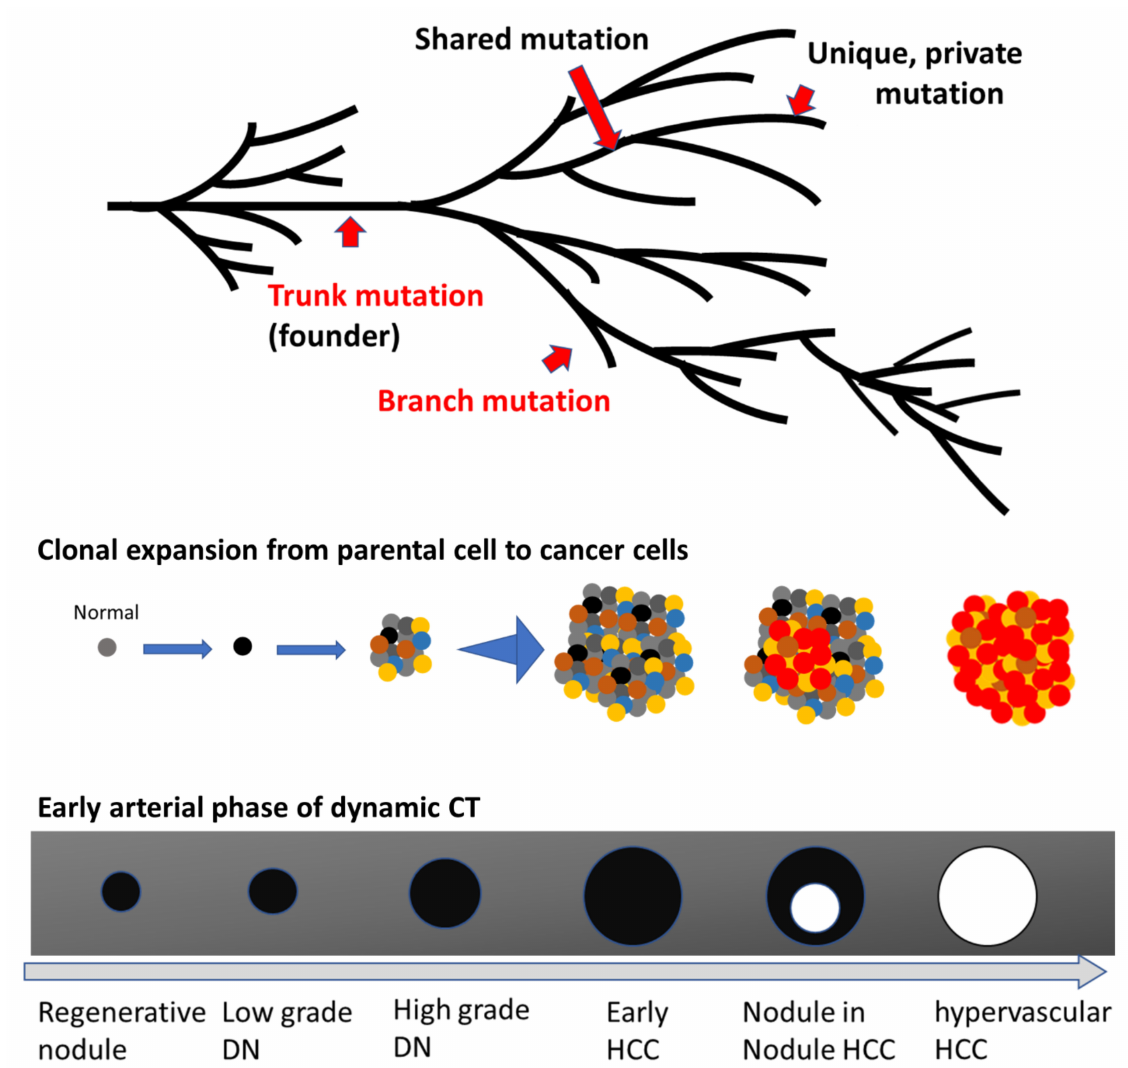
Figure 2. Scheme of the multistep evolution of typical hepatocellular carcinoma (HCC) The upper scheme is a phylogenetic tree showing a scenario of the progression from a normal cell to an advanced HCC. Examples of trunk and branch mutations in addition to shared as well as unique mutations are shown by red arrows. The middle scheme depicts the evolutionary progression from parental cancer cell to dysplastic nodule (DN), early HCC, classical HCC, and, finally, metastatic HCC. Each colored dot indicates a tumor cell with a different mutational profile, and each nodule consists of various tumor cells with distinct genetic alterations, contributing to intratumoral heterogeneity. The red dots indicate progressive tumor cells. This scheme omits nonepithelial cells such as vessels and fibrotic tissues. The lower scheme describes the typical radiological change of liver nodules during multistep hepatocarcinogenesis via nodule-in-nodule HCC, shown in the early arterial phase of contrast-enhanced dynamic computed tomography (CT) imaging. The black areas indicate nodules described as hypovascular areas in the early arterial phase of dynamic CT, whereas white circles mark hypervascular nodules in the early arterial phase of dynamic